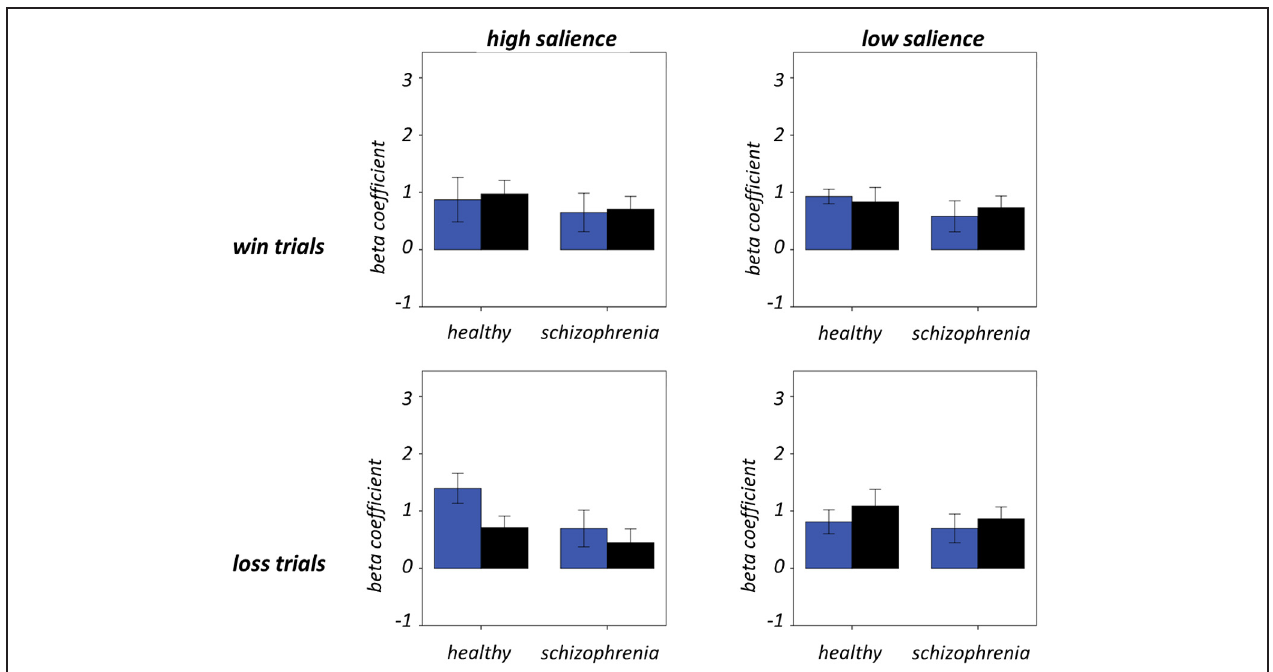
FIGURE 8 | Anterior cingulate cortex component activity at trial outcome. Condition-specific beta coefficients are shown, with blue and black bars denoting hit and miss trials, respectively. Error bars denote standard error of the mean.